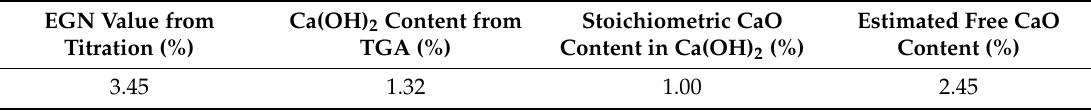
Table 6. Free lime content of the LMF slag